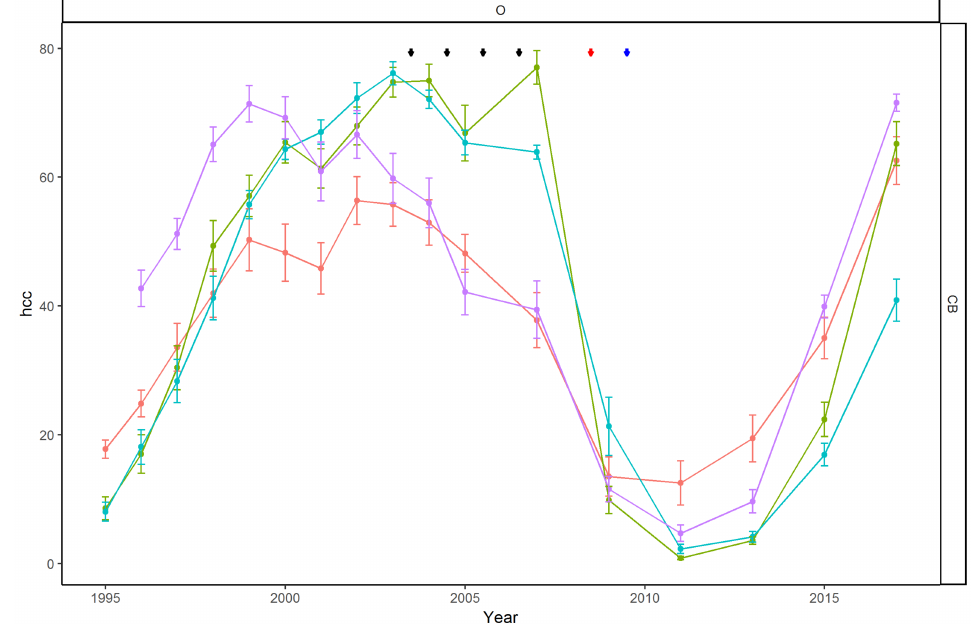
Figure A2. Temporal trends in hard coral cover in the Capricorn-Bunker sector of the Great Barrier Reef. Data are mean percent hard coral cover ± 1 SE for reefs on the outer-shelf (O). Colour arrows show the occurrence of disturbances: black = coral disease, red = sub-cyclonic storm, blue = Cyclone